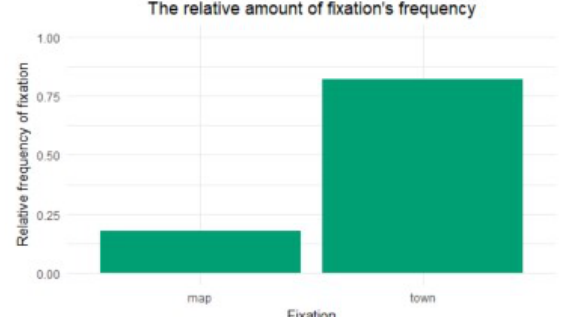
Figure 4. The relative frequency of fixations on them map (left) vs town (right)